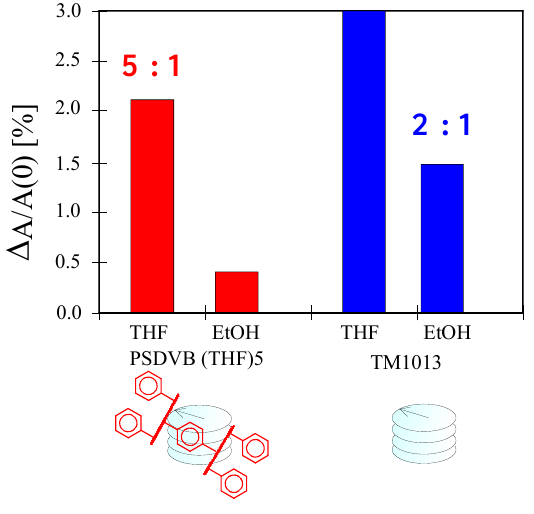
Figure 5. Selectivity comparison of pure and imprinted CLCs in a cross linked polymer matrix (THF imprinted) for THF and EtOH sensing indicating imprinted one is more selective [5:1] while pure CLCs has [2:1].